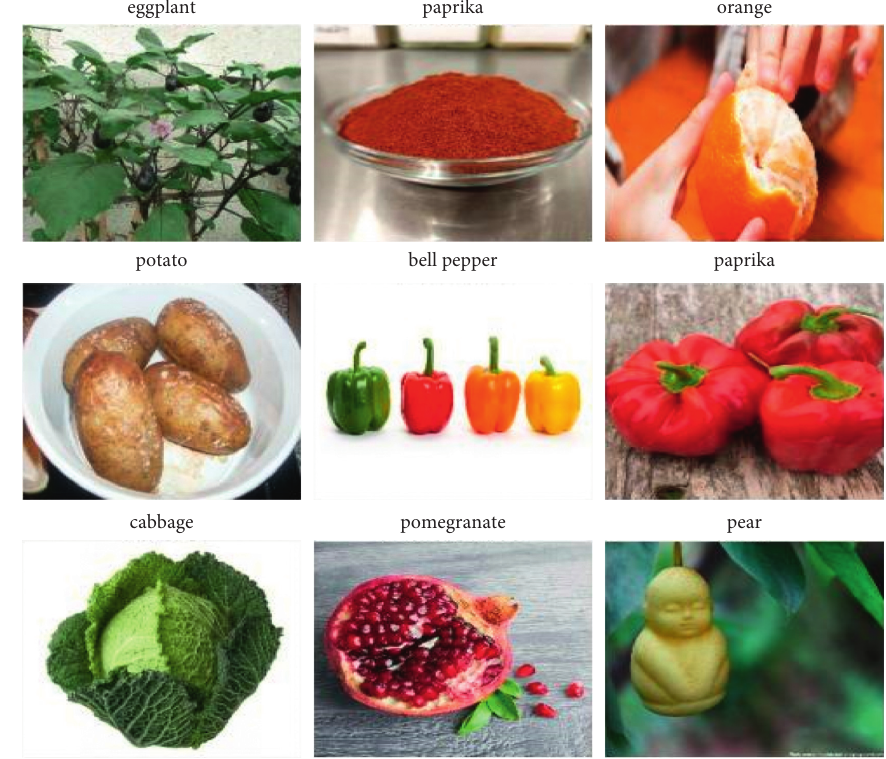
Figure 10: Dataset used for